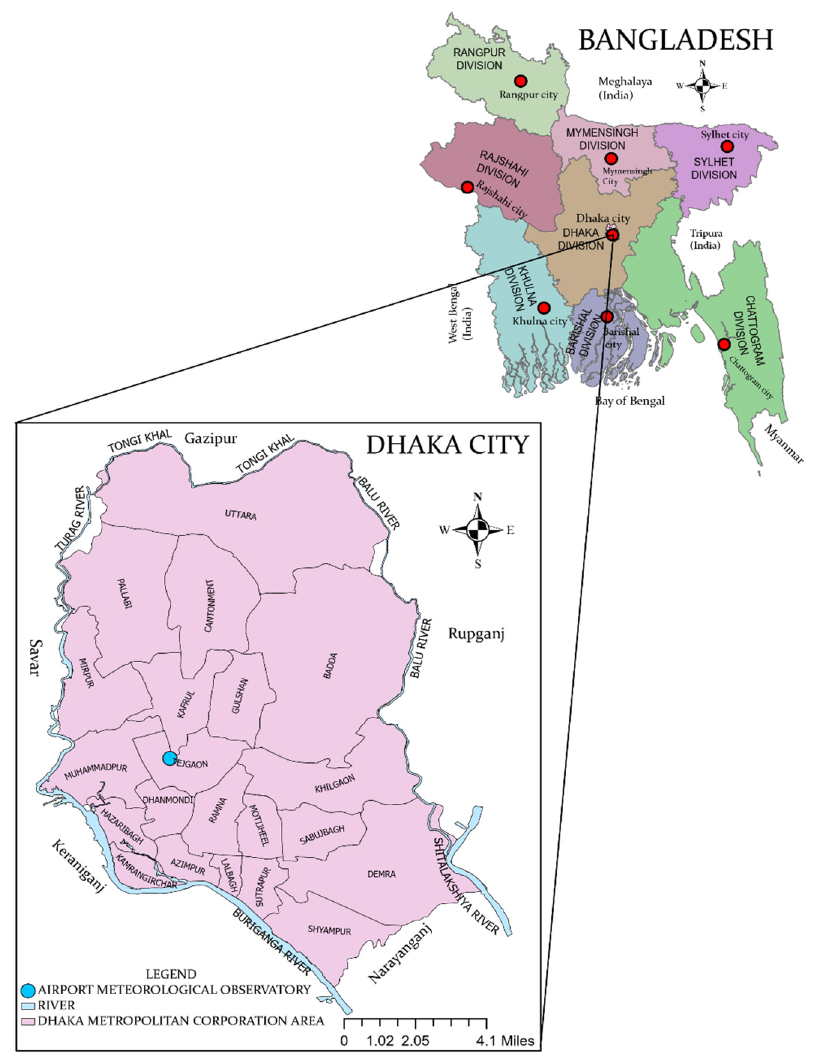
Figure 2. Location map of the study area—the City of Dhaka, Bangladesh.